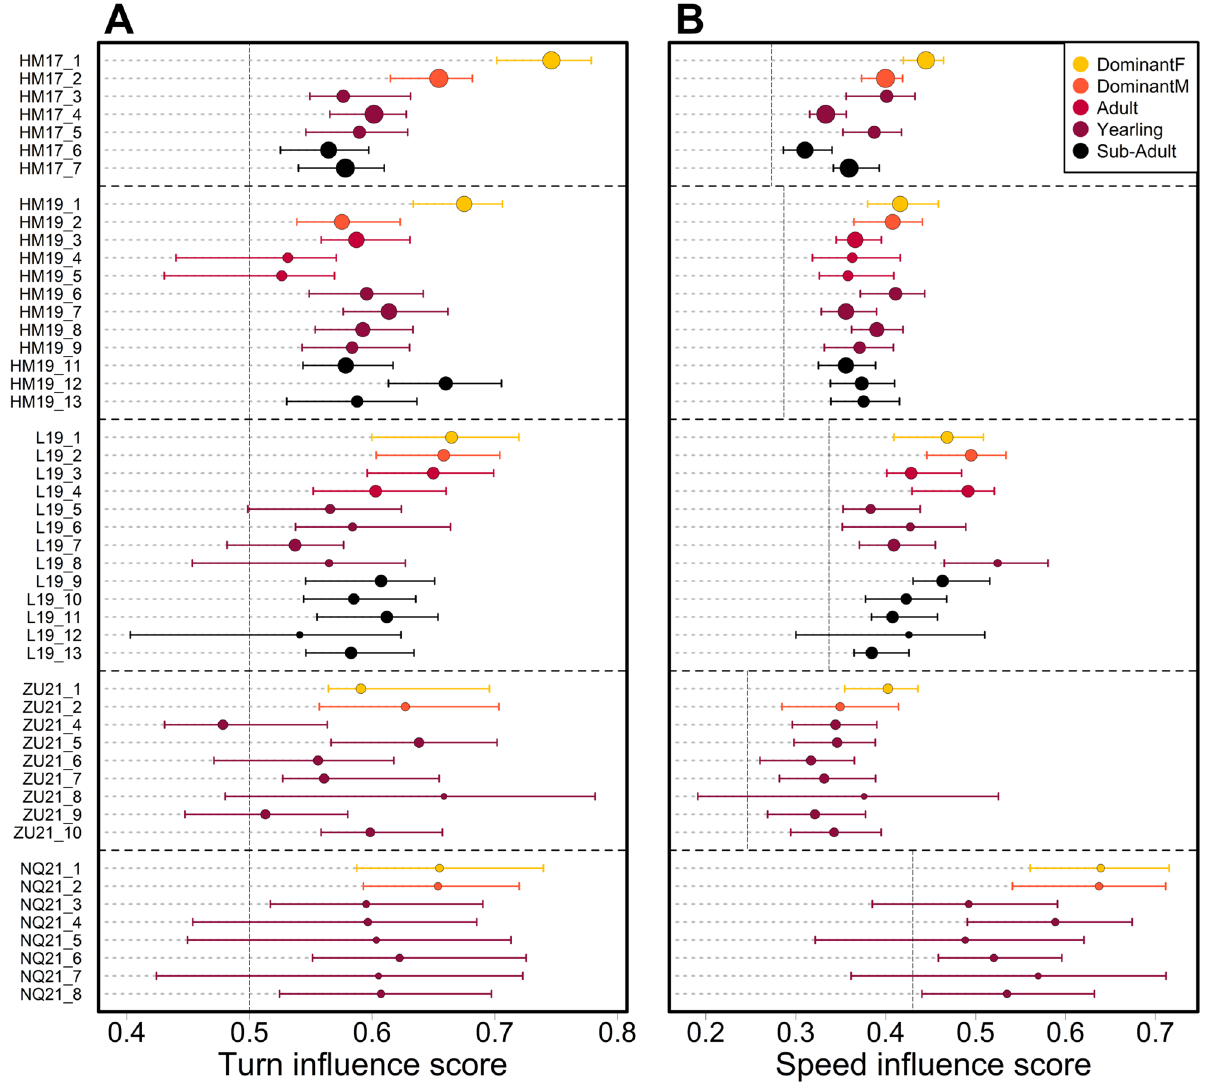
Figure 2. ( A ) Turn influence and ( B ) speed influence scores for each recorded individual (colored dots) in the 5 study groups (vertical axis). Dot color indicates individual status, with dot size proportional to the quantity of data available. Error bars show bootstrapped 90% quantiles (see Supplemental Materials Sect. 1c for details). Dashed vertical lines represent baseline probabilities for the outcome of group decision. This baseline value is 50% for turn influence (equal probability of turning left or right), and is set to the overall probability to speed up for each group for speed influence (because groups tend to accelerate in rapid bursts and then slow down more gradually, the baseline probability of a group speeding up is not 50%—see Supplemental Materials Sect.